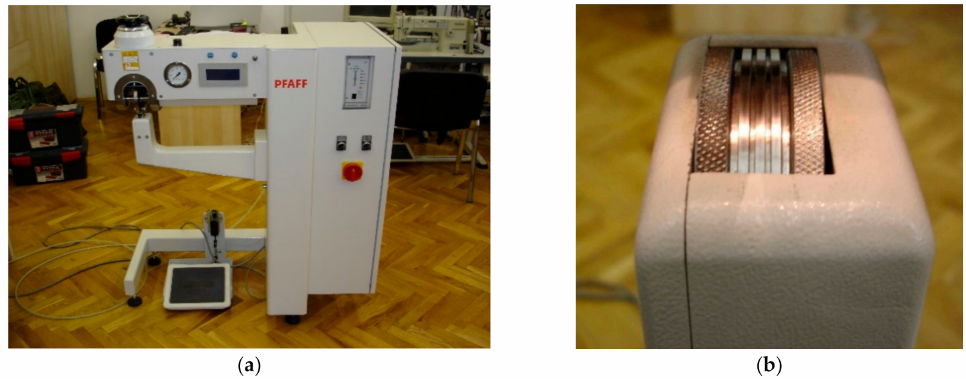
Figure 2. The machine for ultrasonic joining: ( a ) the machine; ( b ) lower engraving